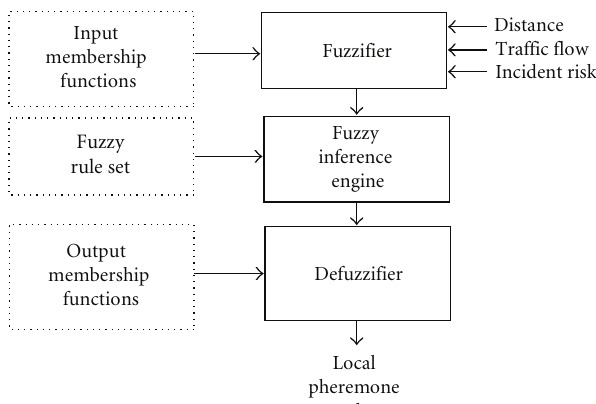
Figure 6: Architecture of the fuzzy logic system for FLACS.